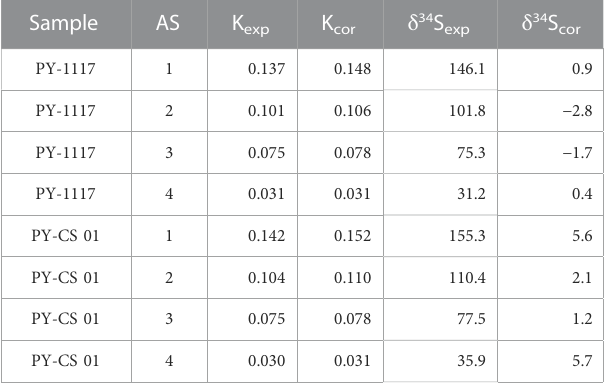
TABLE 1 The sulfur isotopic data of QSA correction and the K values measured using various aperture slits on the standards of PY-1117 and PY-CS01. Sample